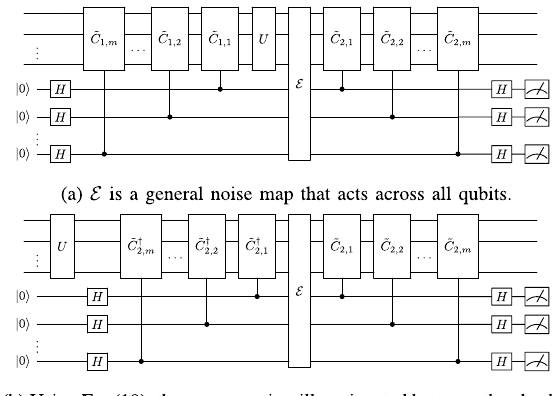
Figure 6. Noisy multilayer